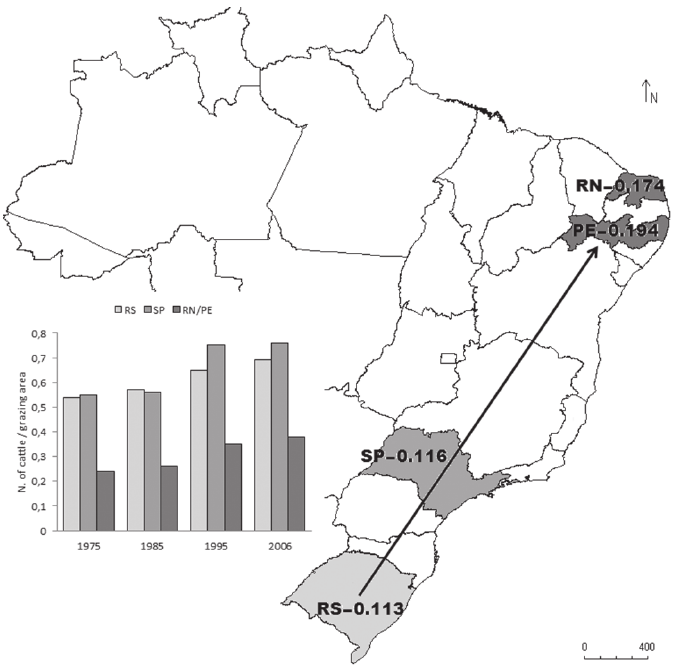
Figure 1. Map of Brazil showing states were cattle egret ( Bubulcus ibis ) populations were sampled. Levels of differentiation (F st values) between each Brazilian population and the total African population are shown. Arrow indicates probable path of colonization. Histogram shows the number of cattle per grazing area in four periods (10 years apart) in the states